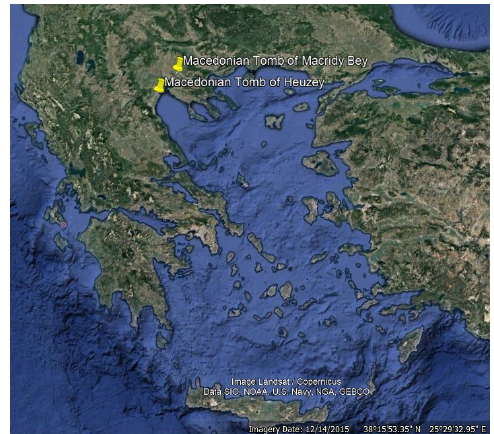
Figure 1: The location of the two Macedonian tombs in Northern